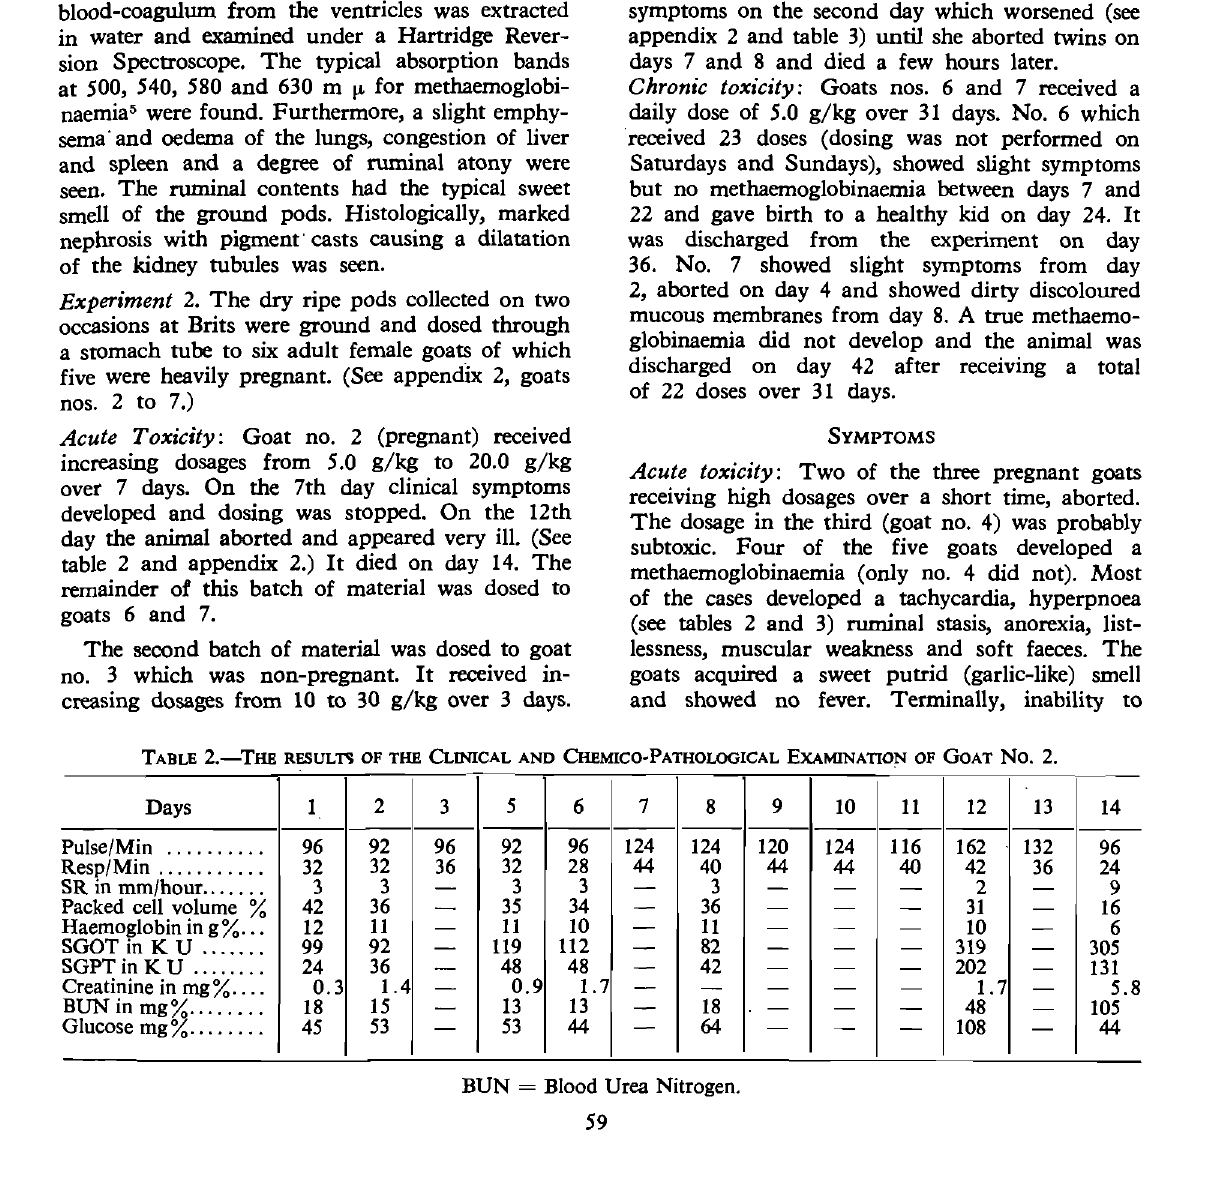
TABLE 2.-THE RESULn OF THE CLINICAL AND CHEMICO,PATHOLOGICAL EXAMINATION OF GOAT No.2.